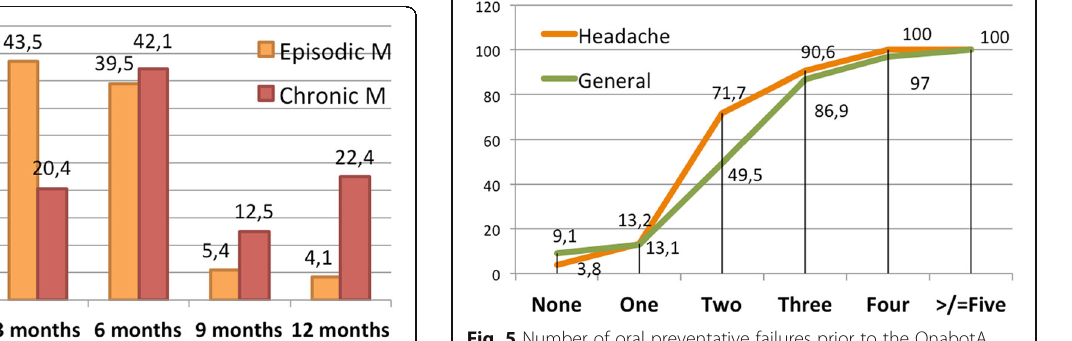
Fig. 4 Optimal duration of preventative treatment according to surveyed neurologists. Numbers represent the percentage of responders that answered each duration. Orange bars represent episodic migraine; red bars represent chronic migraine